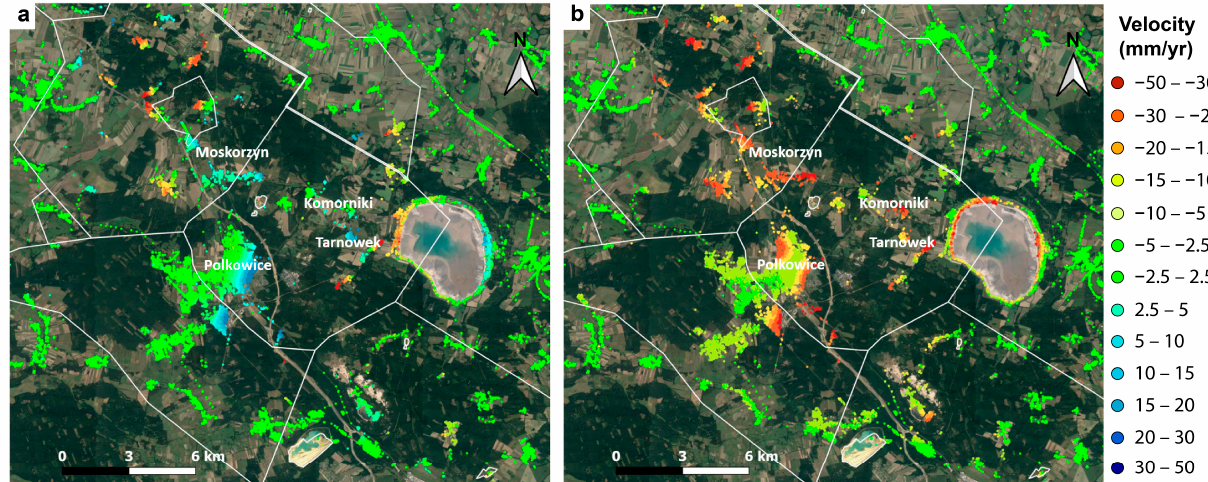
Figure 3. A ‐ DInSAR Displacement velocity maps of the Legnica Glogow Copper mining District (LGCD) for the time period October 2014–April 2019; ( a ) horizontal displacement velocity map, along the east ‐ west direction; green color represents stable areas, cyan, and blue colors represent the displacement towards the east, while orange and red colors represent the displacement towards the west; ( b ) vertical displacement velocity map, along the up ‐ down direction; green color represents stable areas, orange, and red colors represent subsidence.